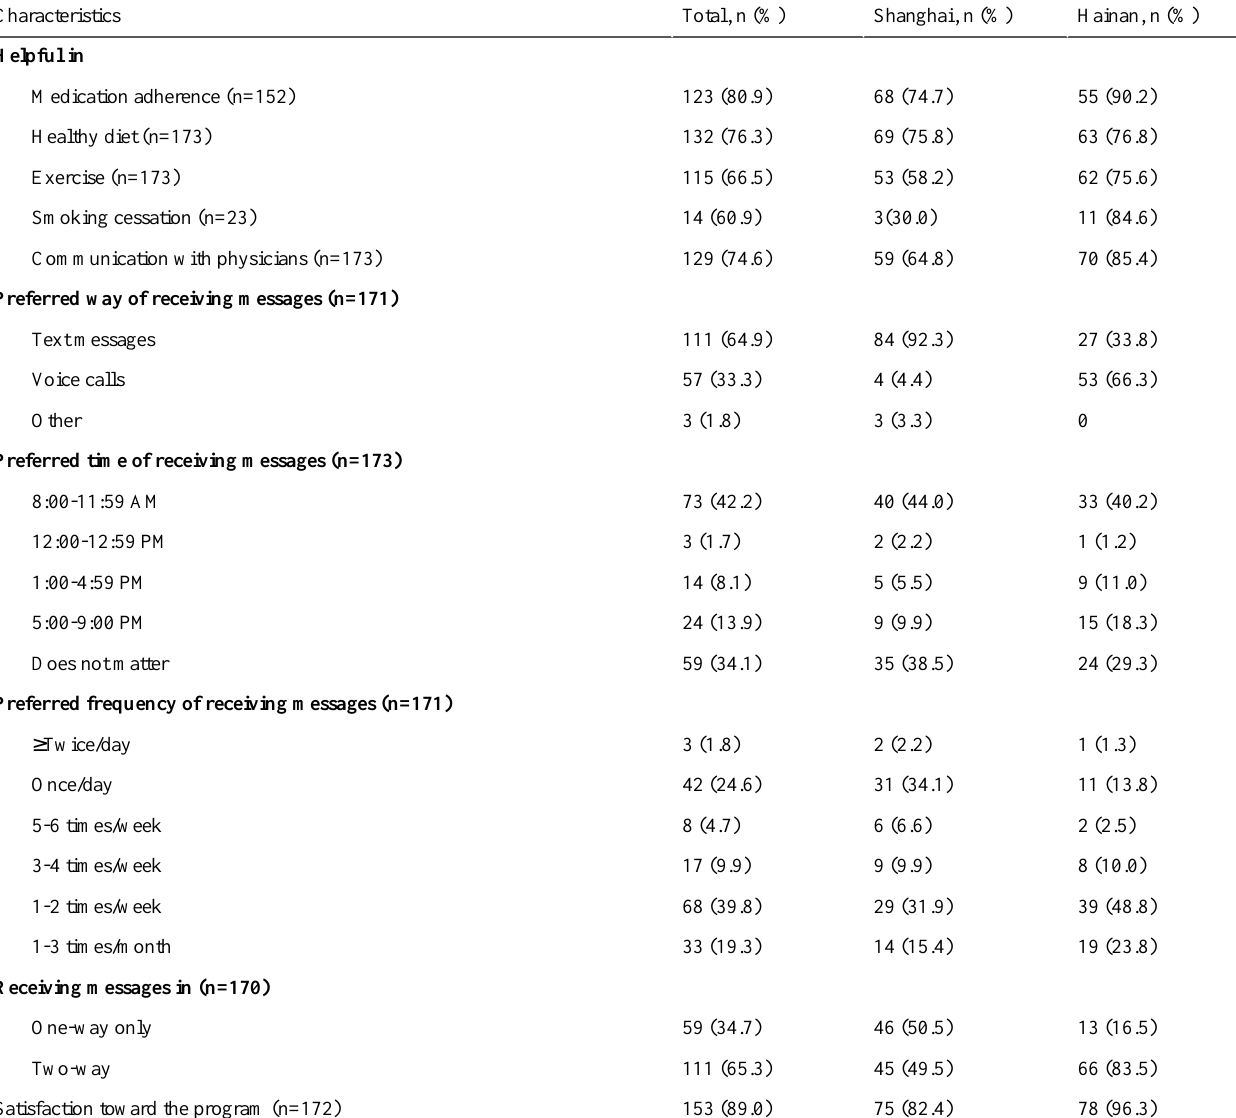
Table 4. Perceived helpfulness of the intervention program and user